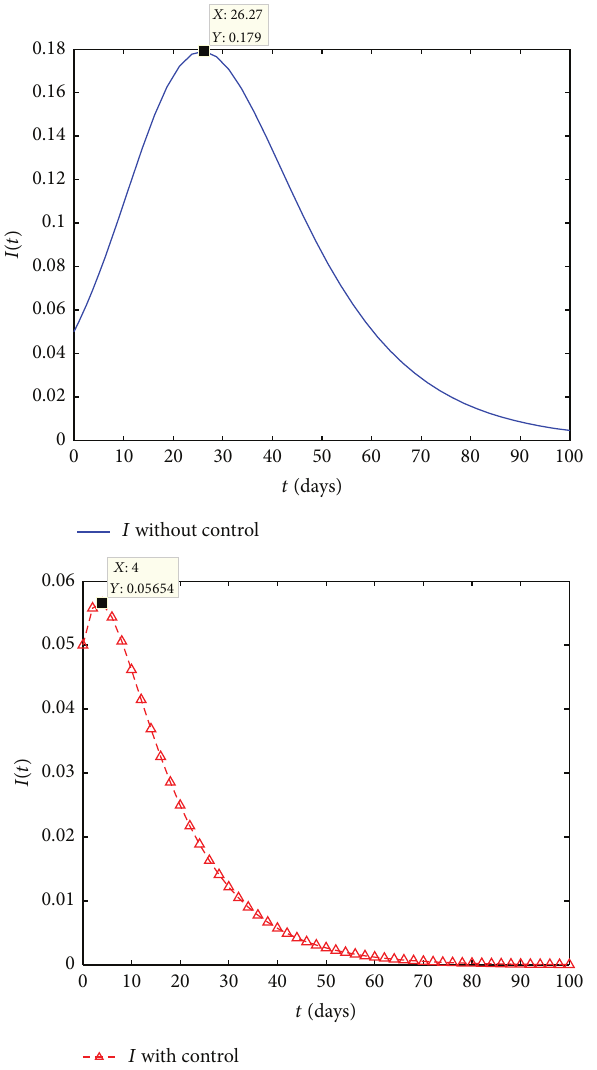
Figure 9: Comparison between the peaks of infected individuals 𝐼(𝑡) in case of optimal control versus without control. Ebola). Note that when 𝑢(𝑡) ≡ 0 model (7) reduces to (5); and when 𝑢(𝑡) ≡ 𝜐 model (7) reduces to (6).